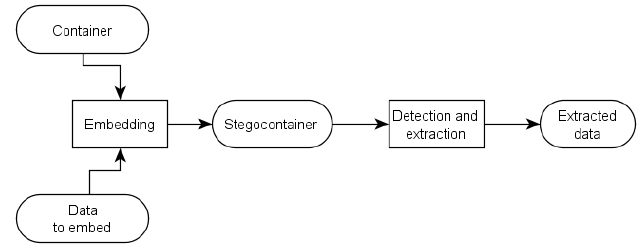
Fig. 1. A simplified steganographic process [1].